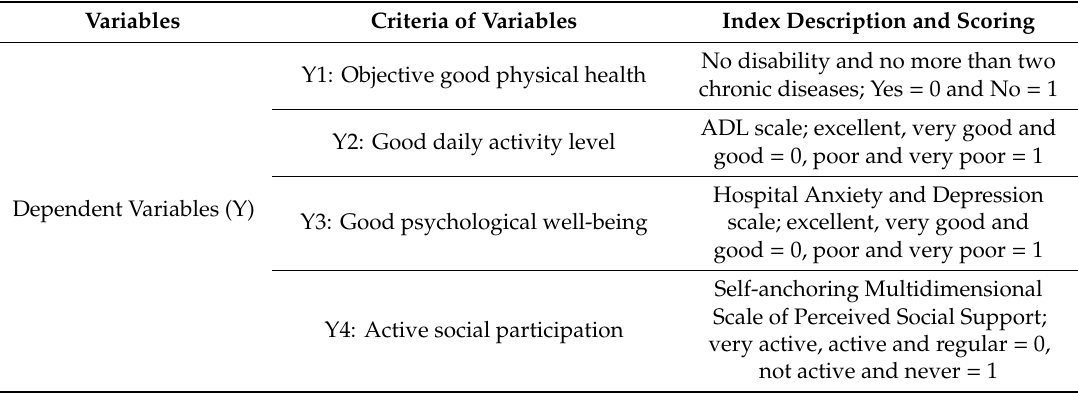
Table 1. Variables and descriptive